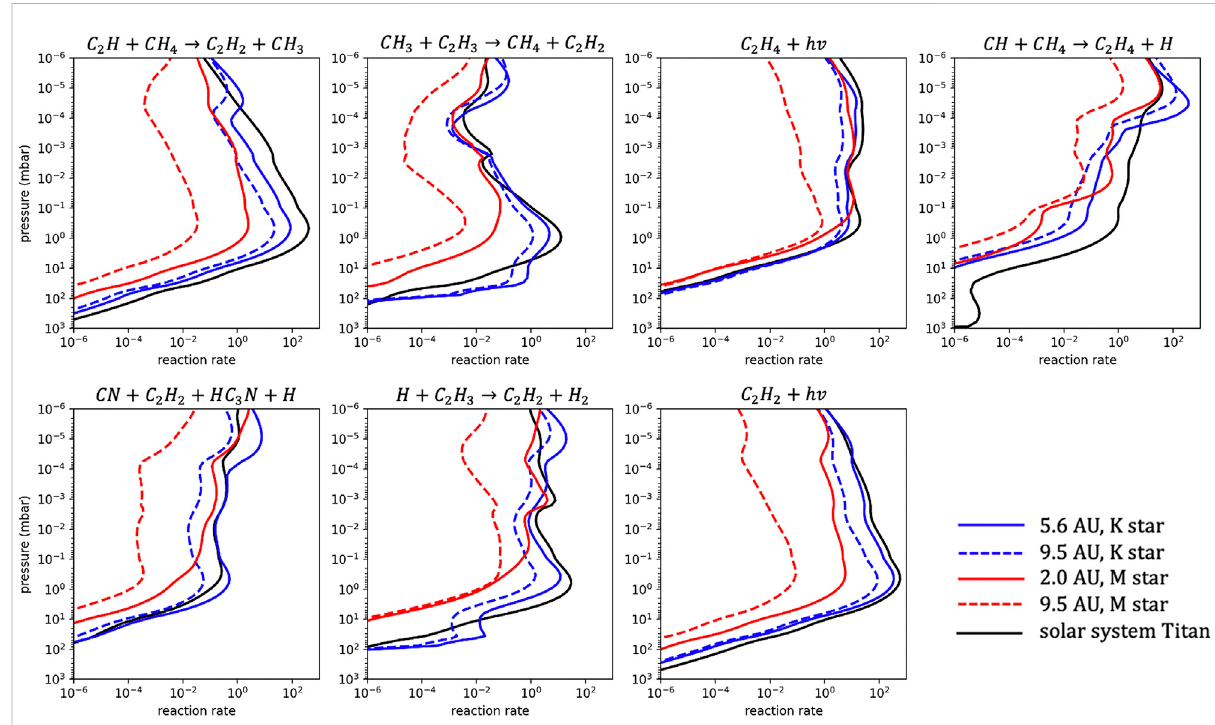
FIGURE 4 Reactionrates(cm − 3 · s − 1 )ofdominantproductionanddestructionreactionsforC 2 H 2 andC 2 H 4 .BlacklinesrepresentsolarsystemTitan,solidred lines represent Titan around an M-Dwarf at 2 AU, dashed red lines represent Titan around an M-Dwarf at 9.5 AU, solid blue lines represent Titan around a K star at 5.6 AU, and dashed red lines represent Titan around a K star at 9.5